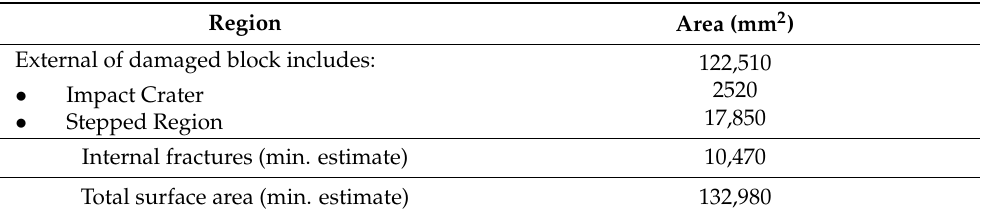
Table 1. Surface area measurements obtained from the 3D model of the damaged Huesca sandstone.